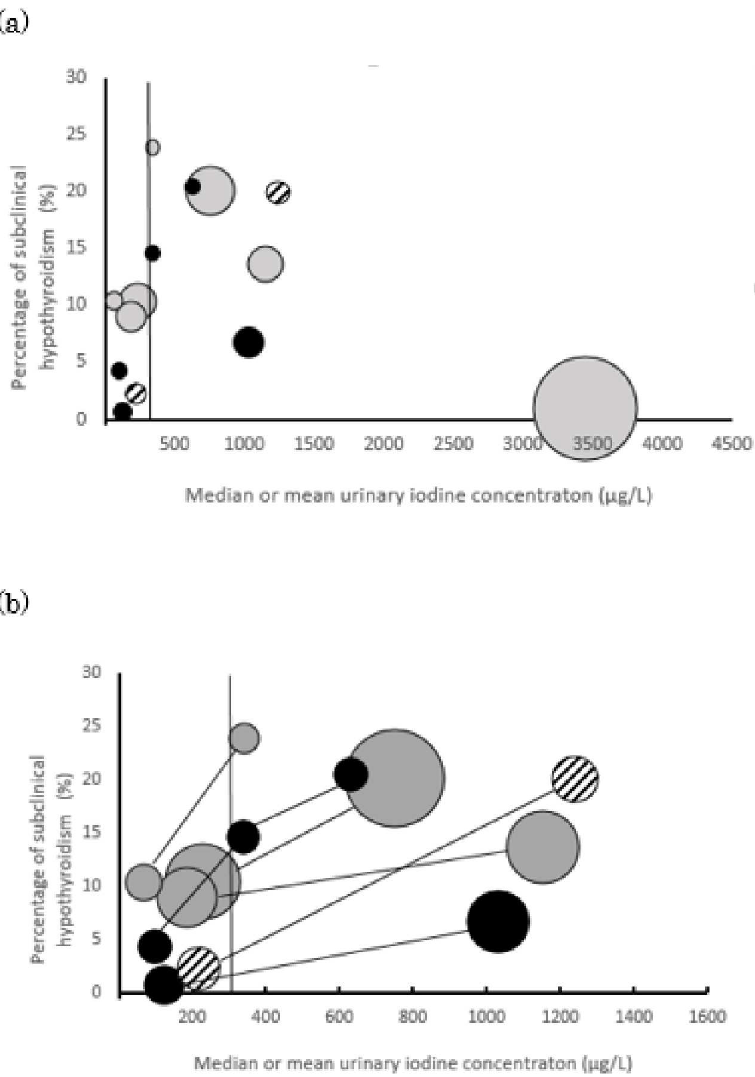
Fig 3. Plots regarding the prevalence of subclinical hypothyroidisim and urinary iodine concentration. (a) Size of a bubbleshowsthe samplesize of the study population. Gray bubblesare from studiesin adults[35– 38],blackbubbles are for children[44,45]andwhitewithblacklineis for pregnantwoman[68].Paperswhich showedboth the percentage of subclinicalhypothyroidismandmedianor meanurinaryiodineconcentration wereincluded. PaperswhichdescribedUIC in categoriesanddid not showthe medianor meanwas excluded from this figure[43,66,67].Verticallineof 300 μ g/Lis shown. (b) papersincludedin plot (a) andthosecompared in more than two areasin the study wereplotted. Bubbles from the samepaperwereconnected with lines. Colorsof bubblesmeanthe same as (a).